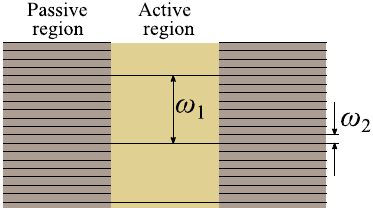
FIG. 11. 1D plasmonic crystal driven by dc current in the oscillating field of THz radiation. FIG. 12. Active regions of the plasmonic crystal with a large fundamental frequency are separated by passive regions with a small